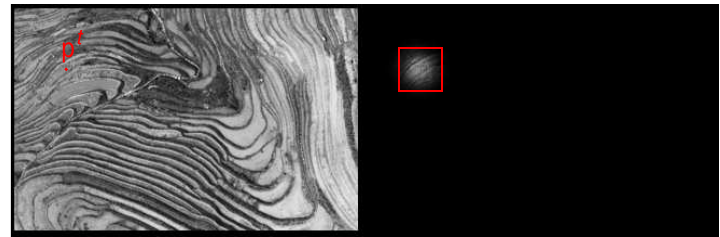
Figure 3. An example of weighting gray image that is based on a feature point p t . The left one is the original terrace gray image, and the right is the weighting gray image. The effect of the weight operator is shown in a red window, and the size of the window is controlled by the parameter τ 2